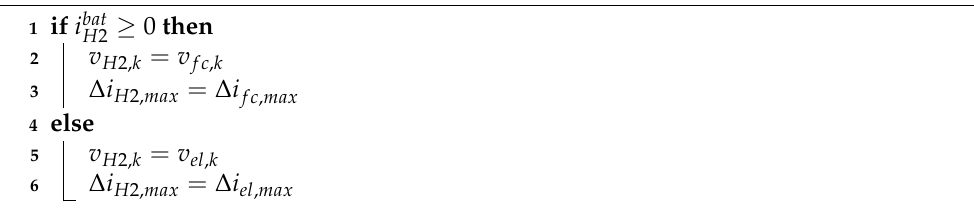
Algorithm 1: Fuel cell and electrolyzer current